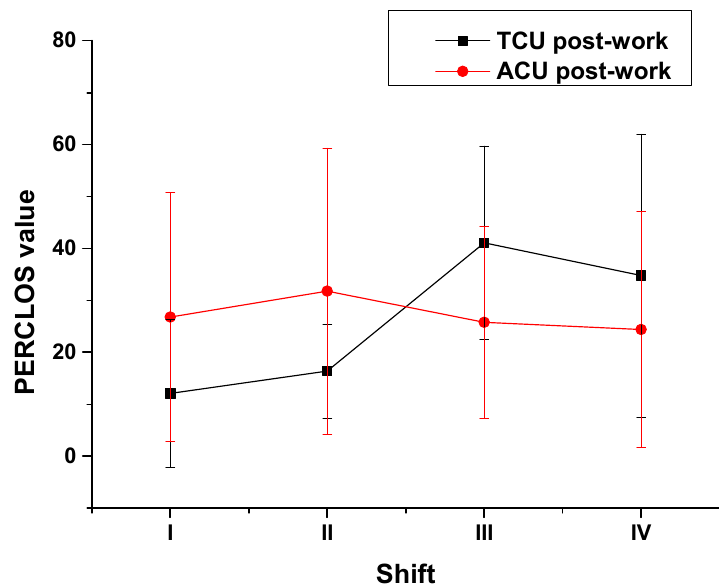
Figure 6. Post-shift PERCLOS values of ATCOs by shift and work type.